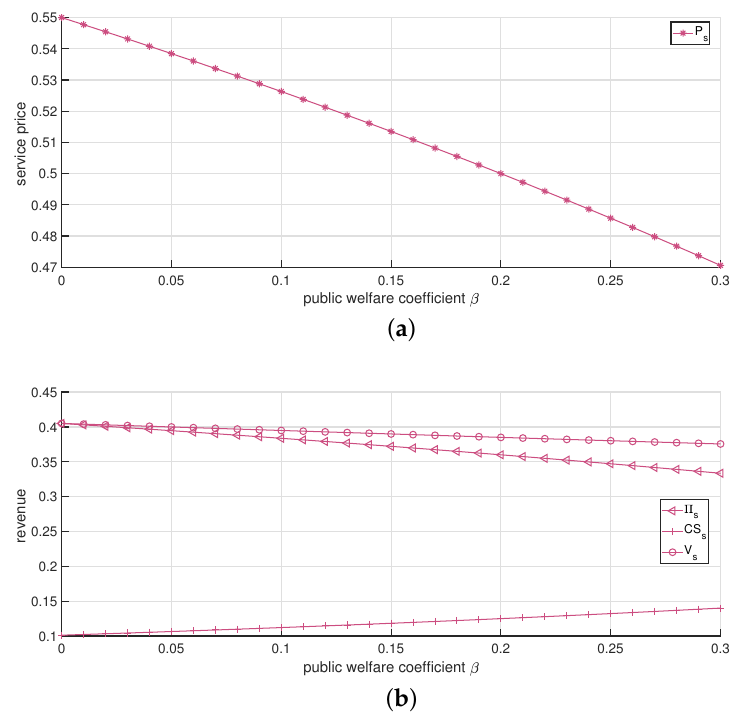
Figure 4. The impact of changes in β by employing the single-channel strategy. ( a ) The impact of changes in β against service price. ( b ) The impact of changes in β against revenue.